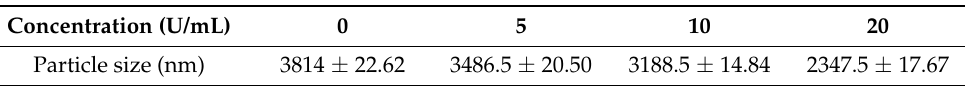
Figure 7. Ability of LcFFase1s to catalyze the hydrolysis of soybean ( a ) and effect of LcFFase1s on the gel properties ( b – d ) of coagulated fermented-soymilk. Table 2. Effect of LcFFase1s on the particle size of coagulated